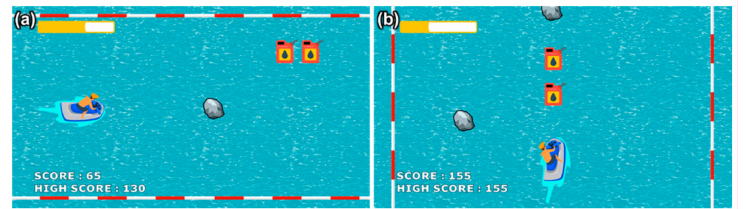
Figure 2. Serious game contents for surface electromyogram (sEMG) measurement: ( a ) forward– backward inclination; ( b ) left–right inclination.